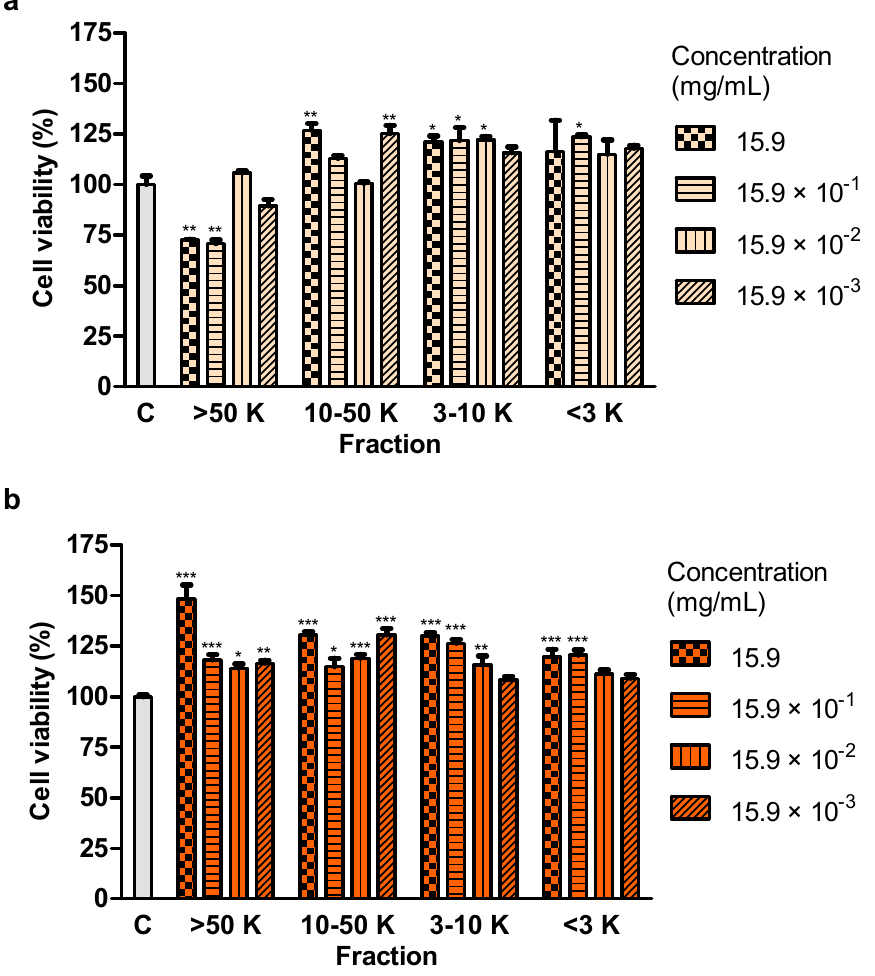
Figure 4. Viability of Caco-2 cells after treatment for 24 h with fractions > 50 kDa ( > 50 K), 10–50 kDa (10–50 K), 3-10 kDa (3–10 K) and < 3 kDa ( < 3 K) of ( a ) juice and ( b ) 50% hydroethanolic extract